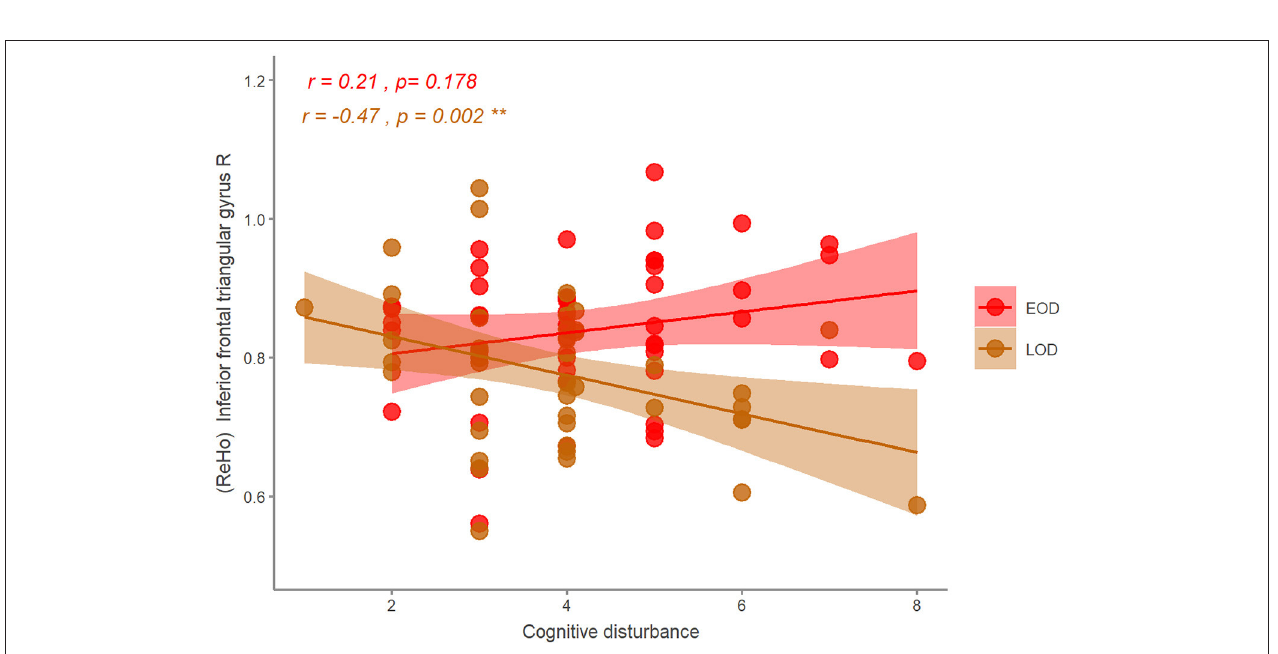
FIGURE 4 | The correlation of the ReHo and HDRS symptom in EOD and LOD patients. EOD, early-onset depression; LOD, late-onset depression. ** p < 0.01.